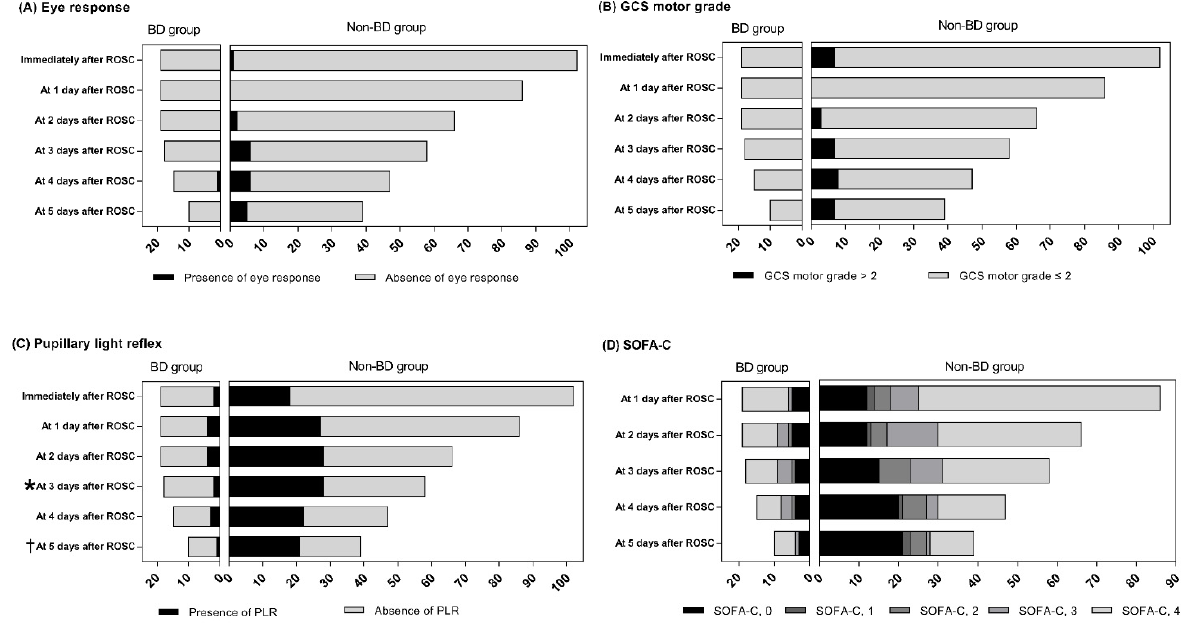
Figure 2. Distributions of in-hospital death patients during 5 days after ROSC between BD and non-BD patients according to Eye response ( A ), GCS motor grade ( B ), pupillary light reflex ( C ) and SOFA-C ( D ). * p = 0.005 and † p = 0.015. BD, brain death; GCS, Glasgow coma scale; SOFA-C, cardiovascular Sequential Organ Failure Assessment score.